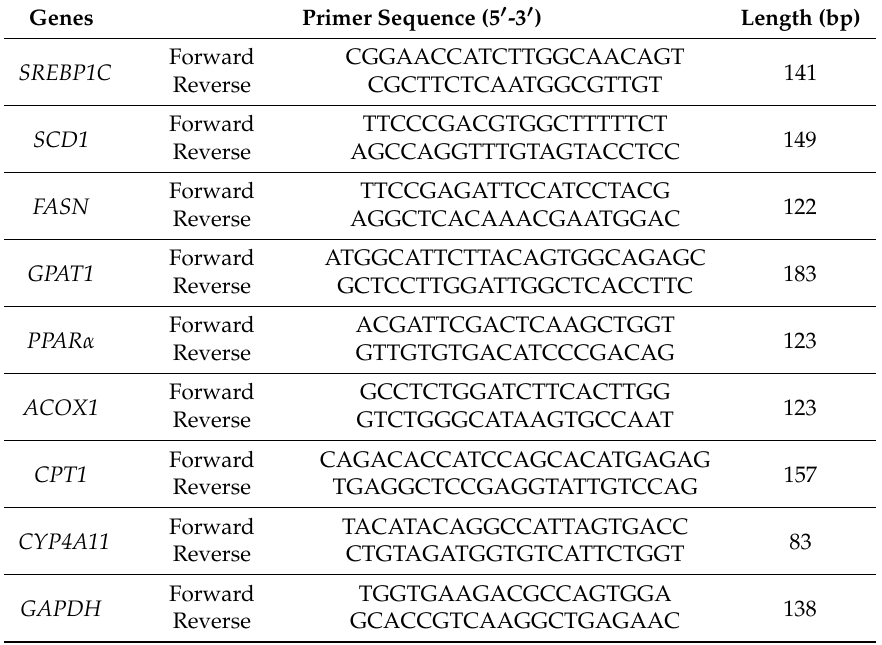
Table 5. Primers for